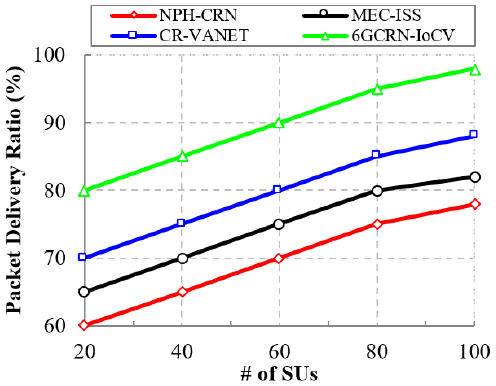
Figure 9. Packet delivery ratio vs. the number of